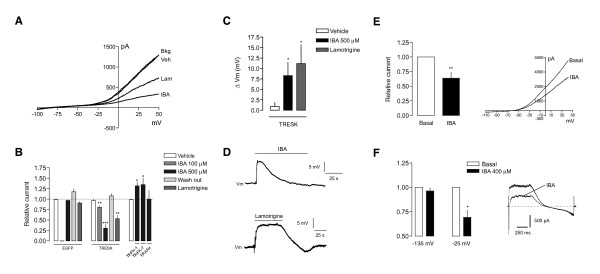
Alkylamides block TRESK channel currents. A. Representative recording of IBA (500 μM) or Lamotrigine (Lam; 100 μM) -evoked inhibition of TRESK in HEK293 transfected cells. Total background currents (Bkg) were recorded in the whole cell configuration of the patch clamp technique (Holding potential = -60 mV). Vehicle (Veh) did not produce significant effects on recorded currents. B. Quantification of IBA and Lam effects on TRESK and other K2P channels. n = 5-7 cells per condition. *p < 0.05; **p < 0.01; ***p < 0.001. t-test vs. resting background currents. C. Quantification of IBA and Lam effects on resting membrane voltage in HEK293 cells transfected with TRESK (n = 4 cells per condition). Membrane voltage was normalized with resting membrane. After achieving the whole cell configuration, the patch amplifier was switched to the current-clamp mode and resting membrane voltage was recorded. *p < 0.05 t-test vs. vehicle application D. Representative membrane voltage recordings of TRESK-transfected cells stimulated with IBA (500 μM) or Lamotrigine (100 μM). E. Effect of IBA (400 μM) on total current from DRG neurons. A voltage ramp protocol from -110 to +50 mV was used. A significant decrease (p < 0.01; n = 6) in total current is seen after IBA application compared to Basal current (before IBA application). F. Effect of IBA (400 μM) on currents from DRG neurons using a protocol composed by a depolarizing pulse to -25 mV (holding voltage -60 mV) followed by a hyperpolarizing ramp to -135 mV (as in Fig 2). Quantification of currents is shown at -25 mV (measured at the end of the pulse) and -135 mV. *p < 0.05 vs. basal current. A representative recording is shown. Some TTX-resistant sodium currents can still be observed.